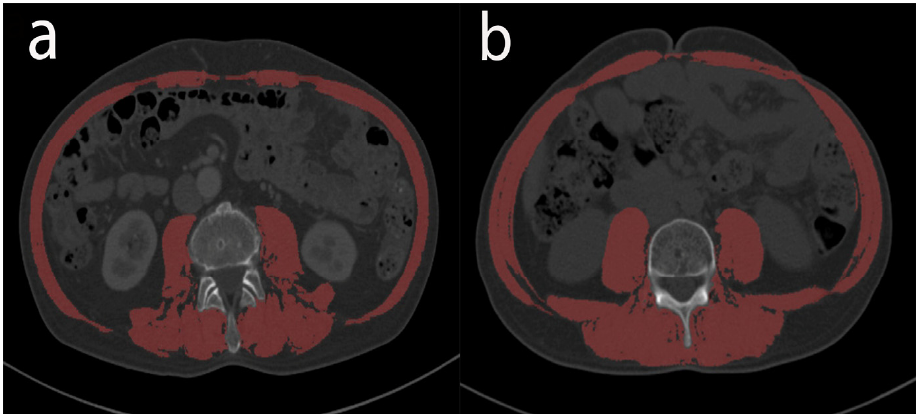
Figure 1. Cross-sectional computed tomography images of the third lumbar vertebra used to measure areas of total skeletal muscle (red shadows): low SMI ( a ); high SMI ( b ). SMI, skeletal muscle index.